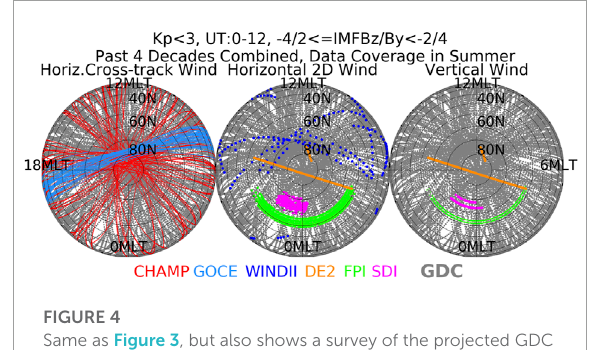
FIGURE 4 Same as Figure 3 , but also shows a survey of the projected GDC geographical coverage (grey). For this survey, the geomagnetic conditions of 2004–2006 are utilized as a proxy for 2027–2029 (GDC prime mission). This figure alone illustrates the power of having constellations rather than single spacecraft missions. In data devoid regions, even 3 years of continuous GDC measurements alone will surpass the past 4 decades of wind measurements